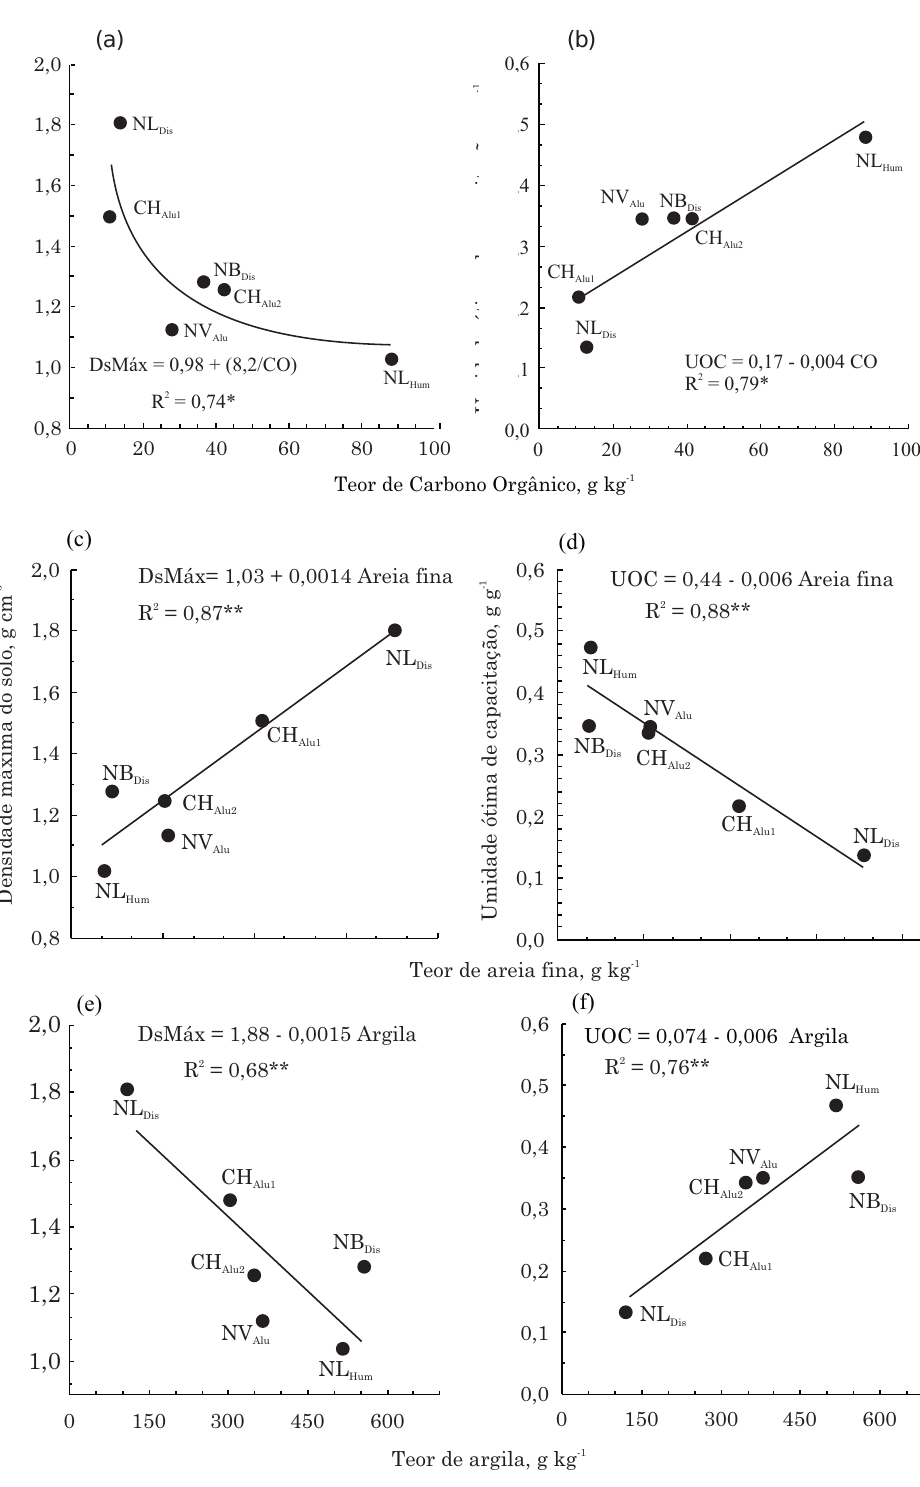
Figura 4. Relação entre o teor de carbono total e a densidade máxima (a) umidade ótima de compactação (b), entre densidade máxima e os teores de areia fina (c) e argila (e) e a relação entre umidade ótima de compactação e os teores de areia fina (d) e argila (f) no horizonte A de seis solos do Planalto Sul Catarinense. CH Alu1 : Cambissolo Húmico alumínico 1; CH Alu2 : Cambissolo Húmico alumínico 2; NV Alu : Nitossolo Vermelho alumínico; NB Dis : Nitossolo Bruno distrófico; NL Hum : Neossolo Litólico húmico, NL Dis : Neossolo Litólico distrófico. * : significativo (0,01<p<0,05) e ** : significativo (p<0,01) pelo teste